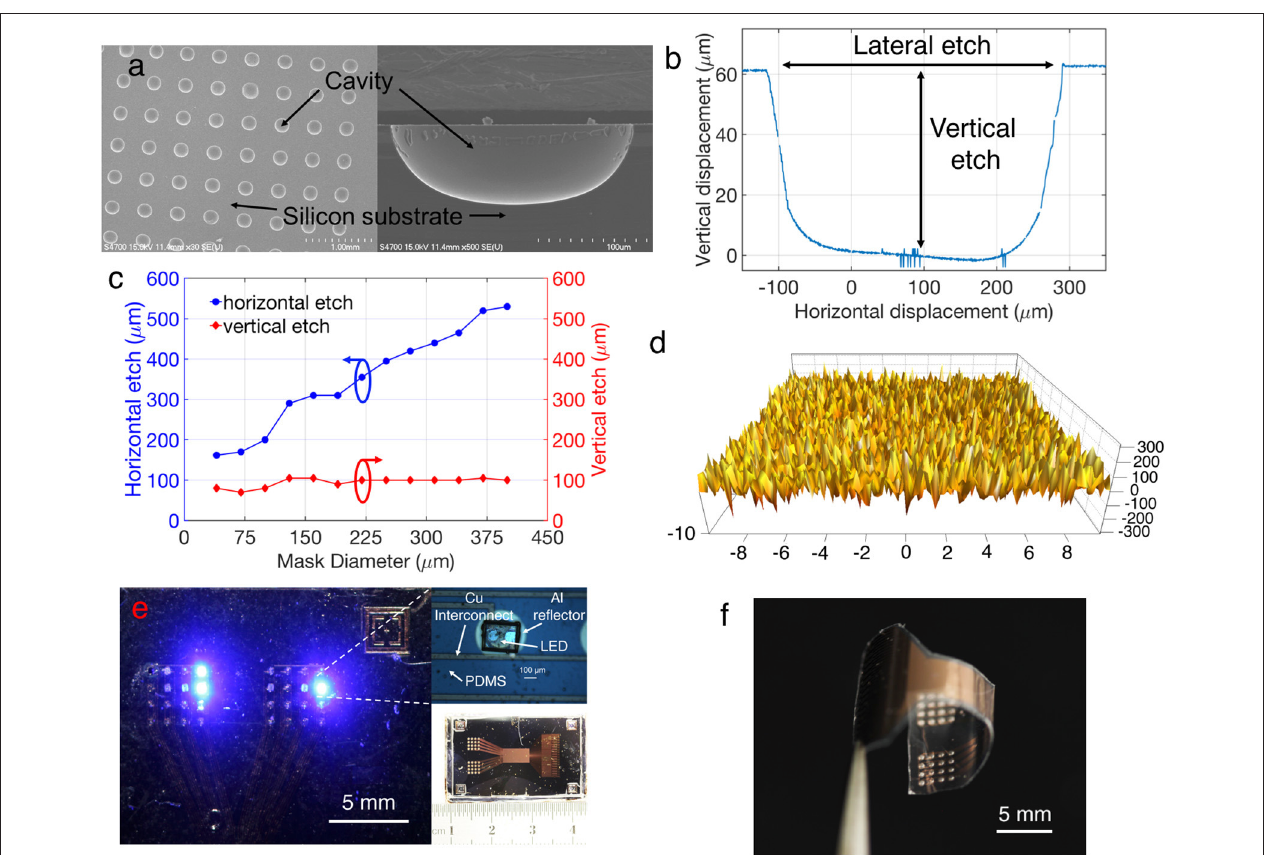
FIGURE 4 | (a) SEM images of the etched silicon cavity. (b) Surface profilometer results for calculating the etched lateral and vertical distances. (c) The etched distance with respect to mask diameter. (d) AFM image showing the smoothness of the etched cavity ( x axis units in µ m, y axis units in nm). (e) A fabricated array stimulator, coupled with the cavity reflector. (f) A released stimulator array before LED